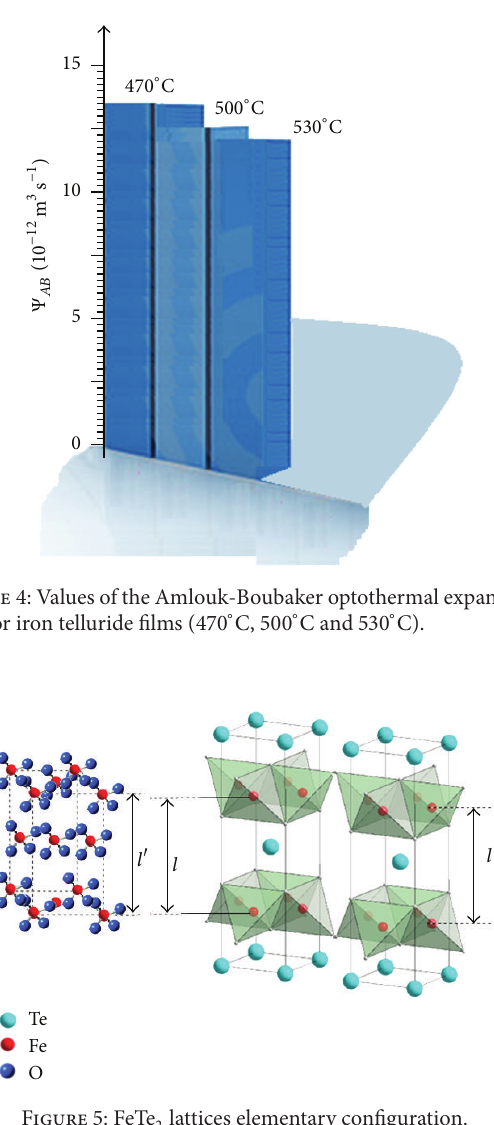
Figure 5: FeTe 2 lattices elementary